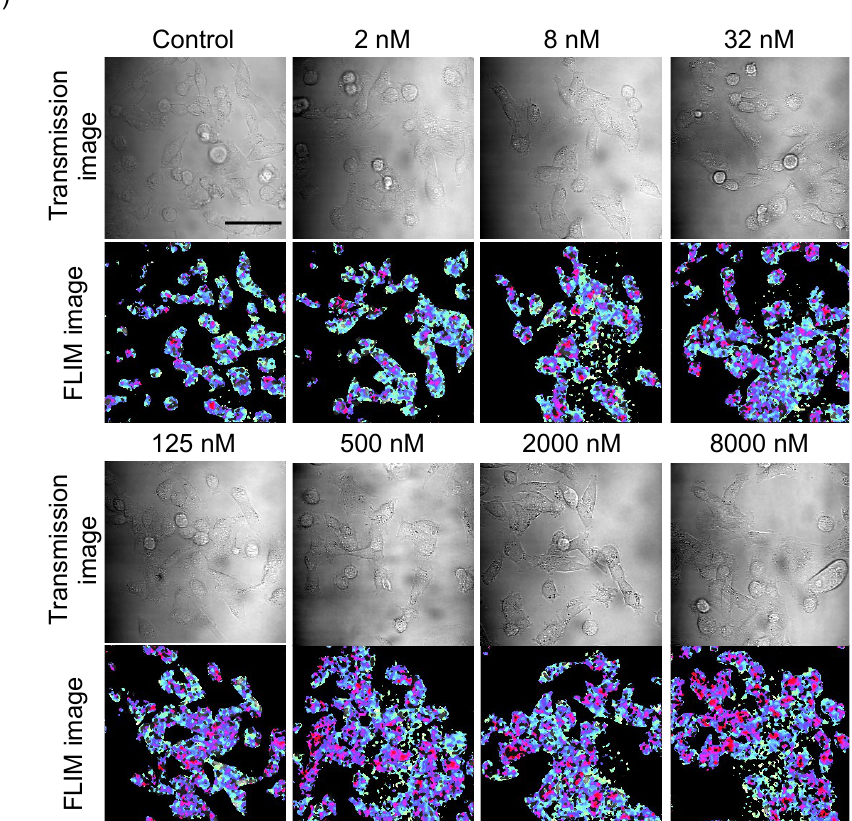
Figure 1. The efective dosage of caffeine on MDA-MB-231 cells. ( a ) Bound NADH fraction at varying concentrations of caffeine on MDA-MB-231 cells. The star (*) indicates significant difference ( p -value < 0.05) ( b ) Representative transmission (top) and FLIM image pseudo colored long lifetime as cyan and short lifetime as red (bottom) associated with each caffeine treatment (bottom) (scale bar: 20 µm).